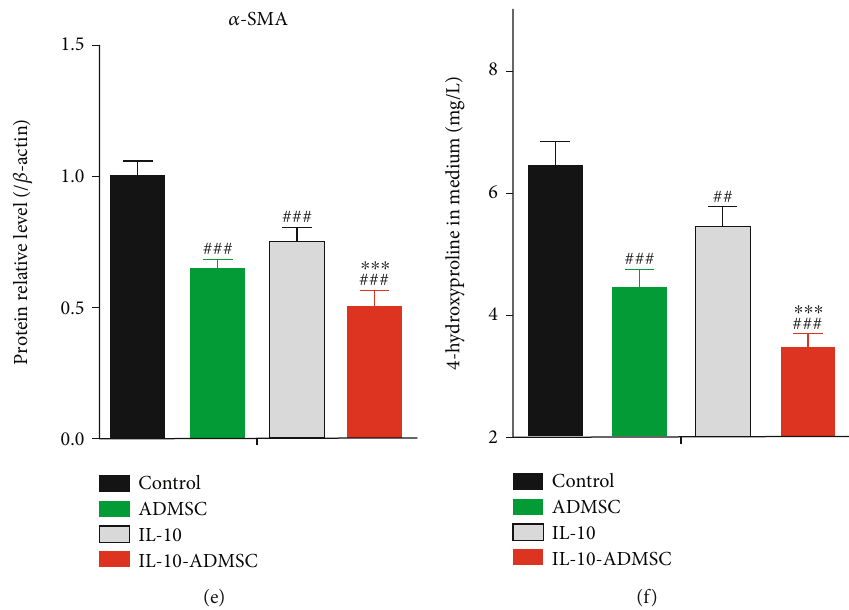
Figure 4: IL-10-modi fi ed ADMSC inhibited the synthesis of extracellular matrix in HSFs. HSFs were cultured alone, or added 1 μ g/L IL-10 in the medium, or cocultured with ADMSC/IL-10-ADMSC for 3 days. (a – e) We harvested the HSFs to detect the expression of collagen-I, collagen-III, α -SMA, and FN protein; (f) we collected the cell culture medium to determine the concentration of 4-hydroxyproline. Data was expressed as ( SD ± mean ), and each analysis was repeated at least 3 times independently; P value was calculated by one-way ANOVA; ∗∗∗ was P < 0 : 001 vs. ADMSC group; ### was P < 0 : 001 vs. control